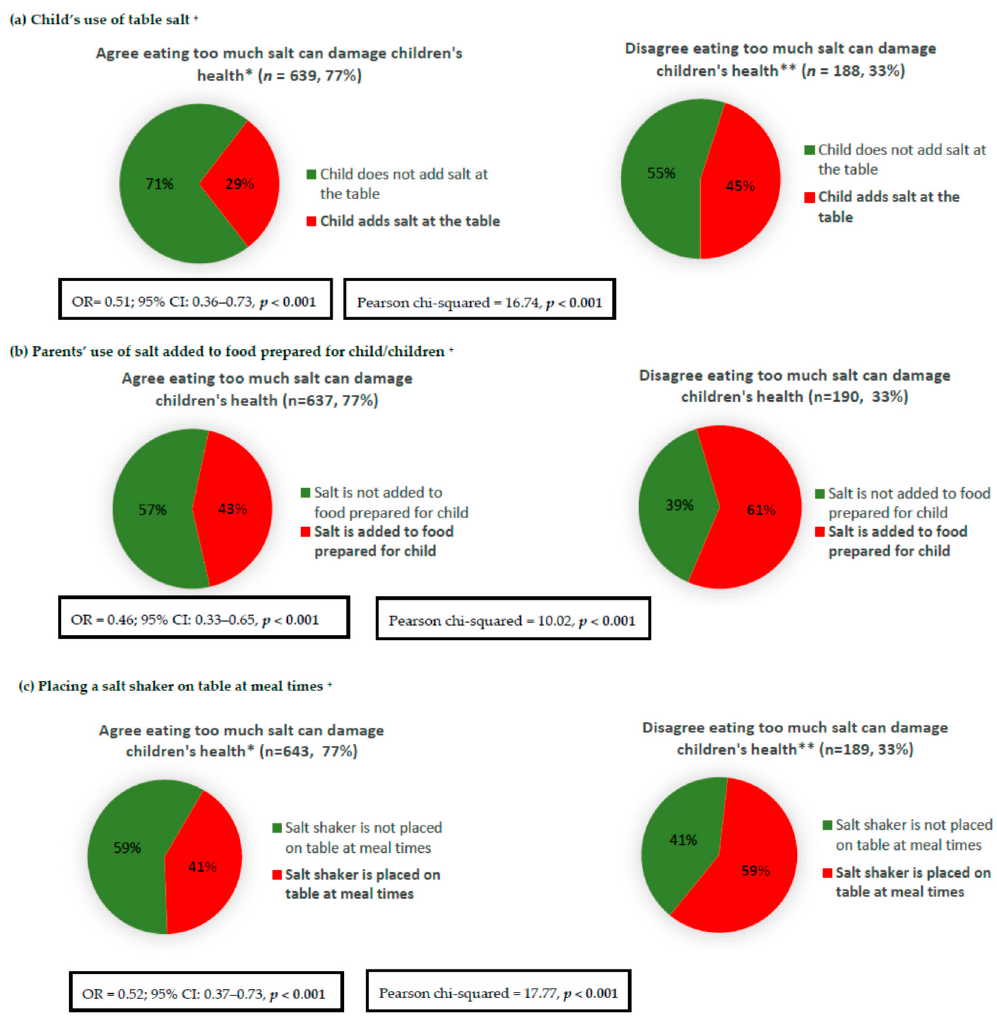
Figure 3. Association between parents’ knowledge of the long term health implications of eating too much salt during childhood and discretionary salt use behaviours related to their child/children. *